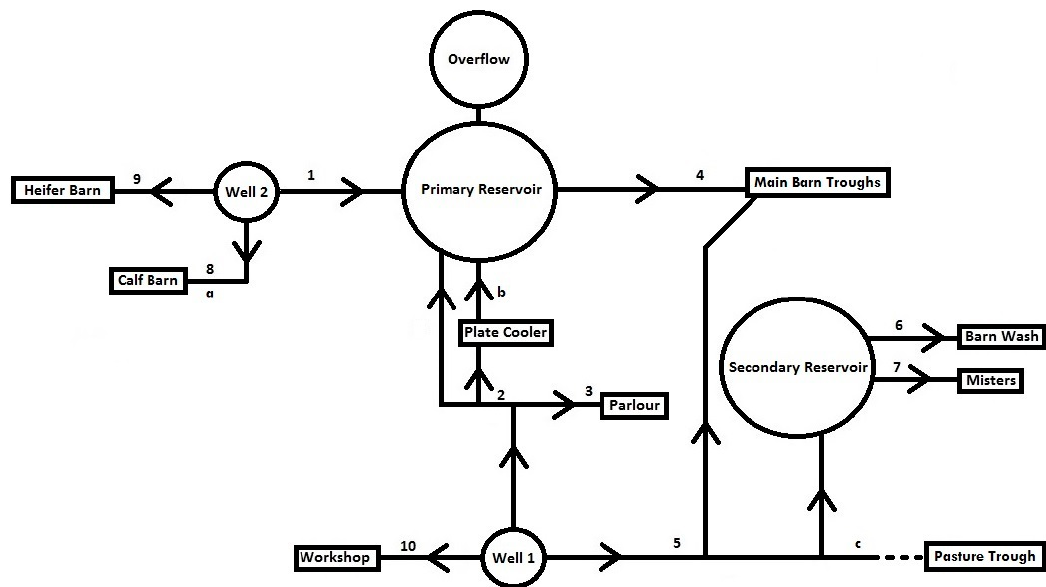
Figure 1. Simplified water flow diagram outlining the location of the 10 in-line flow meters (1–10) and placement of the transit-time flow meters (TTFMs) used to measure water to the calf barn ( a ), from the plate cooler ( b ), and to the pasture trough ( c ). Not to scale.